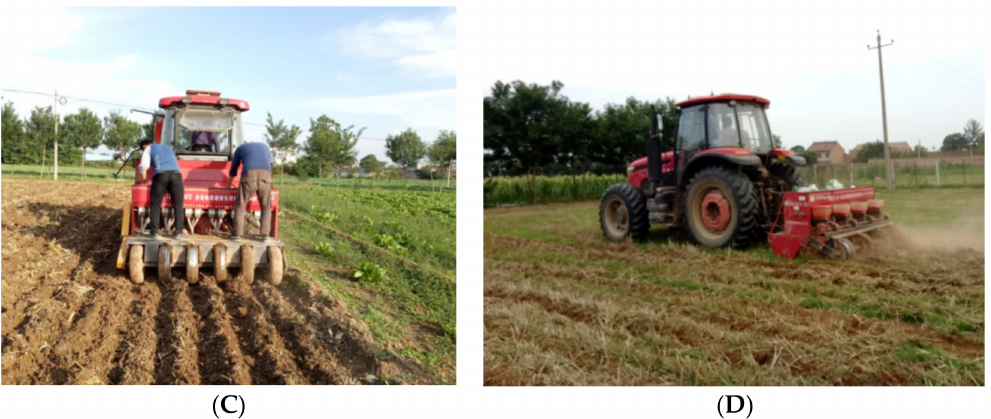
Figure 2. Equipment during the experiments: ( A ) winged subsoiler, ( B ) field subsoiling tests, ( C ) no-till sowing test of winter wheat, and ( D ) no-till sowing test of summer maize. (h, α , and W s stand for wing mounting height, rake angle, and subsoiler width,